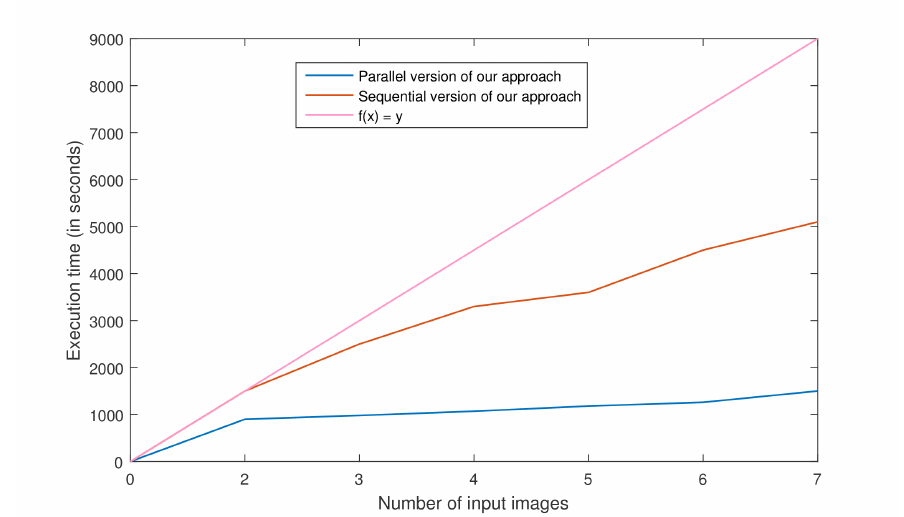
Figure 10. Execution time as a function of the number of input